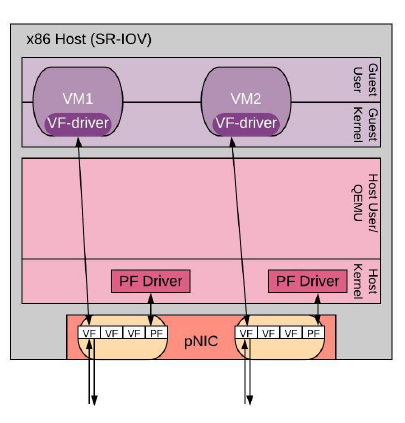
Figure 2. SR-IOV